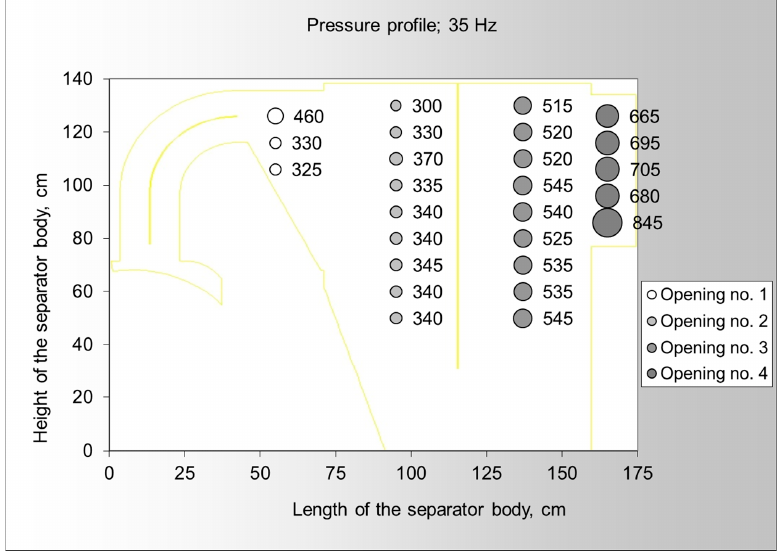
Figure 6. Negative pressure measurements (Pa) carried out at a main fan frequency of 35 Hz. The pressure value at the outlet of the separator was a key input variable needed for the numerical model to work. Therefore, it was essential to accordingly determine the relationship between main fan frequency and the pressure measured at opening no. 4, including the measurement uncertainty. The measurement uncertainties were calculated according to the accuracy of the instrument used (digital pressure gauge) and the estimated experimental error. The characteristic of the used measuring device was as follows: ±(0.1 hPa + 1.5% measured value) in the range of 1.01 to 100 hPa and a resolution of 0.01 hPa. The measured values together with the calculated uncertainties are presented in Table 4. Due to large fluctuations of pressure during the measurements, relatively large error values Δ e x were applied. Table 4. Measured negative pressure at the outlet of the separator for the assessment of the measurement uncertainty.